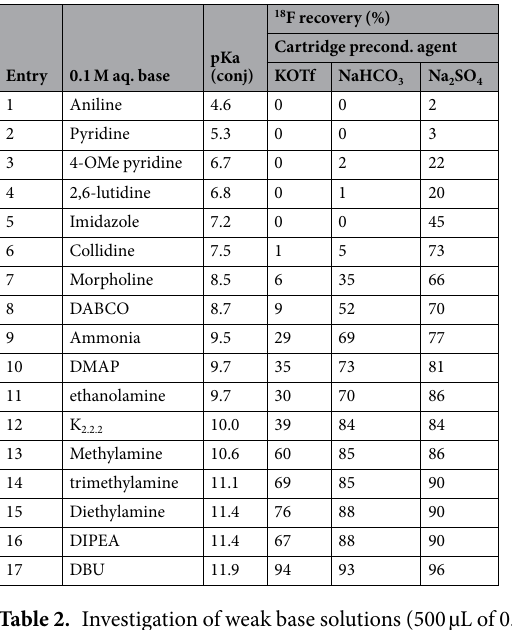
Table 2. Investigation of weak base solutions (500 µ L of 0.1 M aqueous solution) as eluents for [ 18 F]fluoride trapped on Waters QMA-lite cartridges.